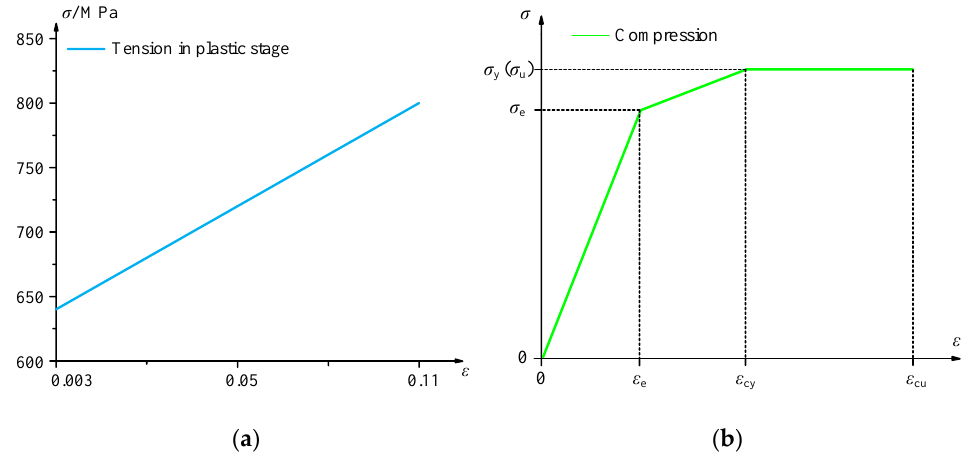
Table 2. Mechanical properties of the GFRP combined with E51.